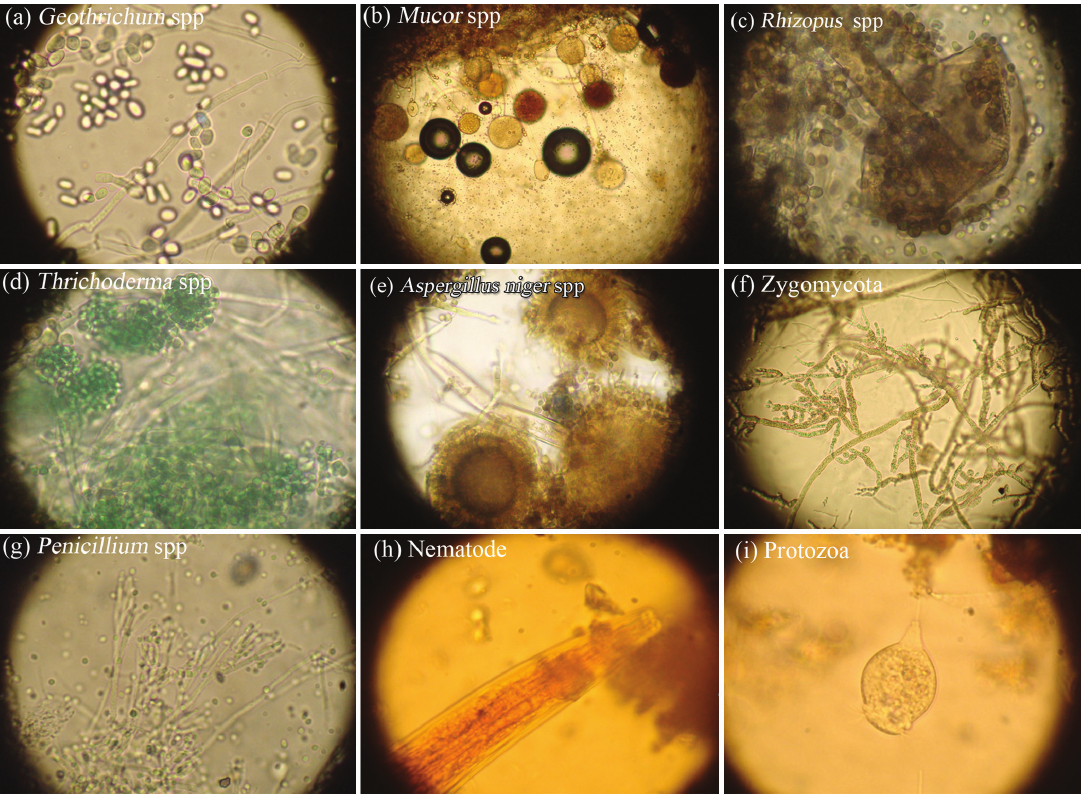
Figure 3. Microorganisms identify during exposure of polyethylene samples in simulated soil: (a) Geothrichum spp, (b) Mucor spp, (c) Rhizopus spp (d) Trichoderma spp, (e) Aspergillus niger spp, (f) Zygomycota, (g) Penicillium spp, (h) nematode and (i) protozoa. Magnification